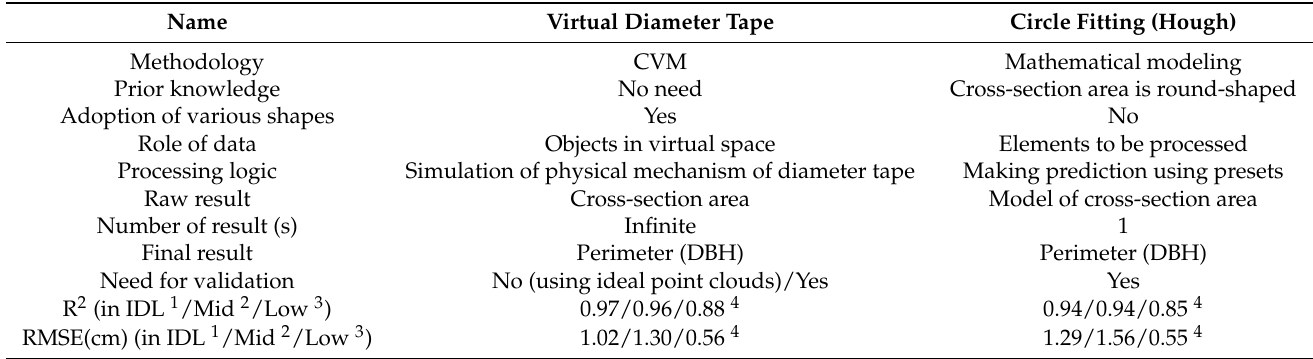
Table 1. Comparison between virtual diameter tape and circle fitting with Hough